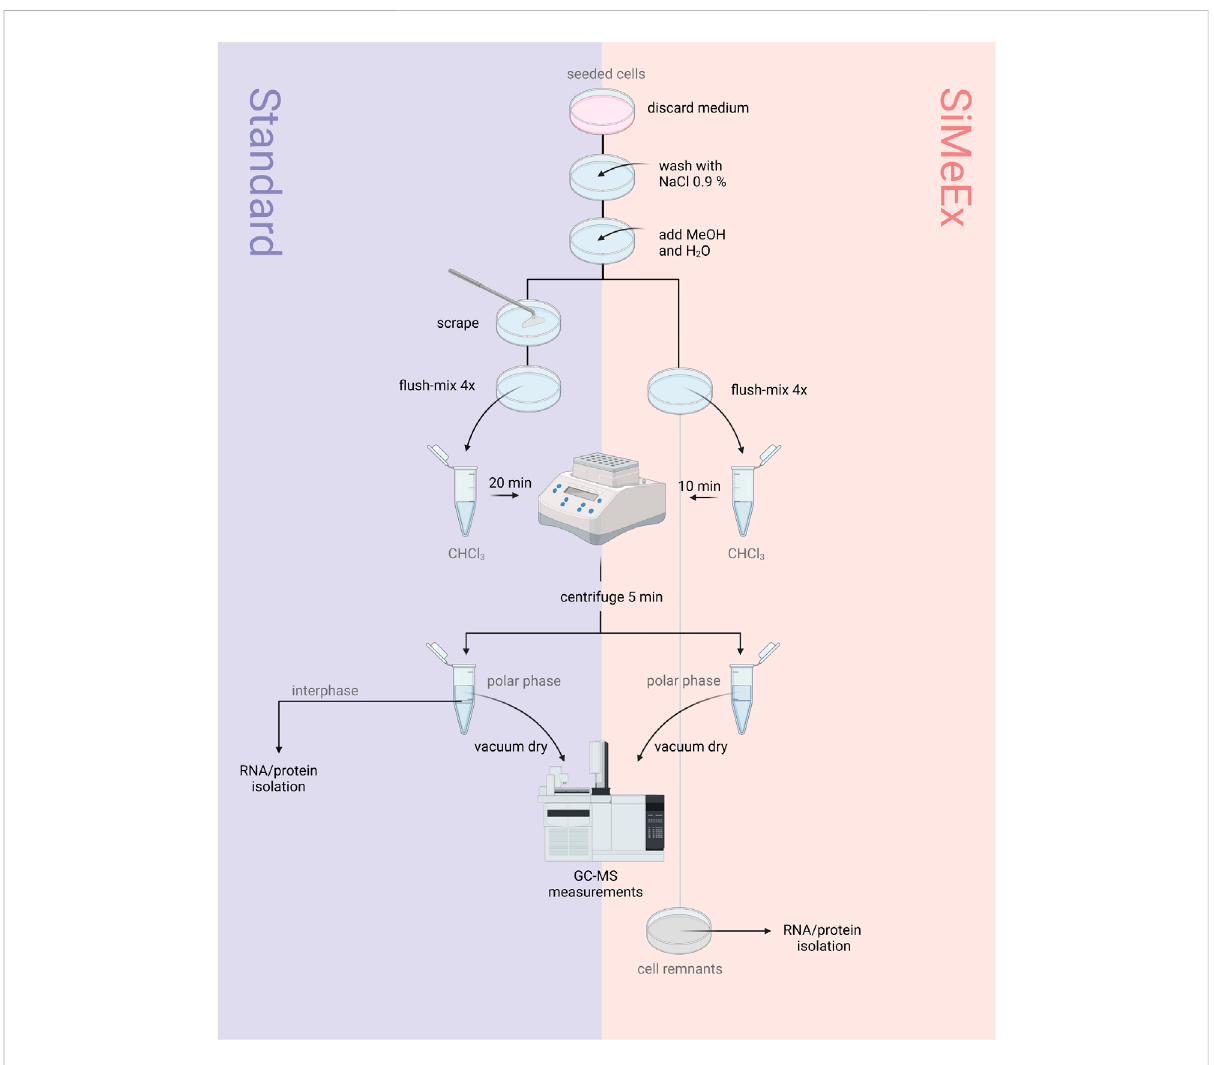
FIGURE 1 ‘ Standard ’ vs SiMeEx. Schematic diagram of the work fl ows for the ‘ standard ’ (left) and SiMeEx (right) metabolite